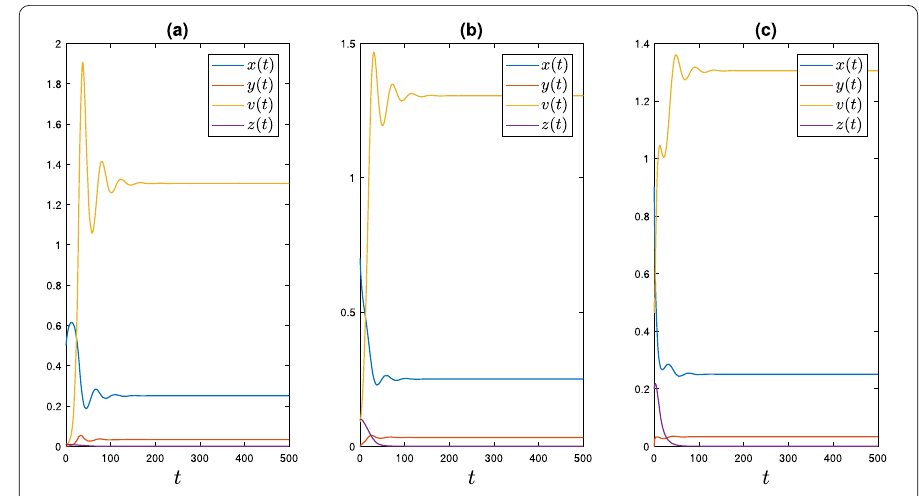
Figure 4 Numerical simulations of model (2) showing the time variation in the size of all relative populations of the model with various initial values. For these simulations, we used the following parameter values: